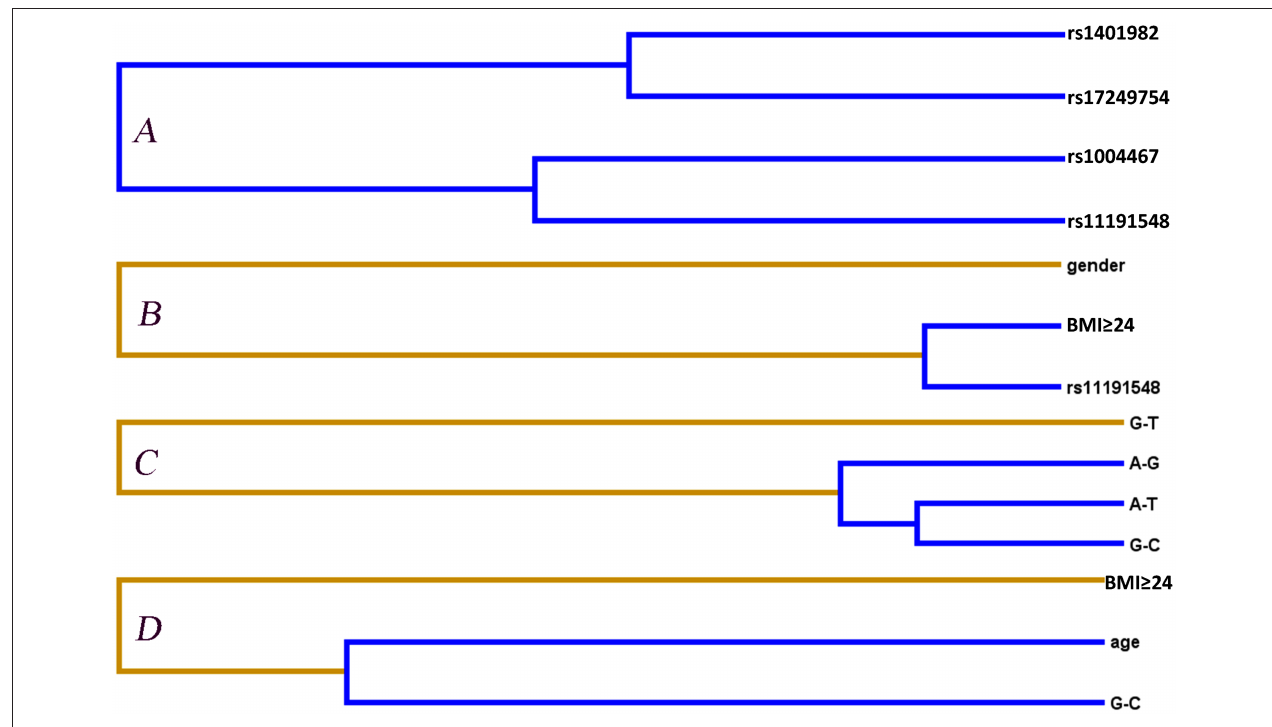
FIGURE 2 | Different types of interaction dendrogram for gene–gene (A,C) and gene–environment (B,D) on the hypertension risk. Orange color (synergy); blue color (strong antagonism interaction). The elements with stronger interaction are closer at the leaves of the